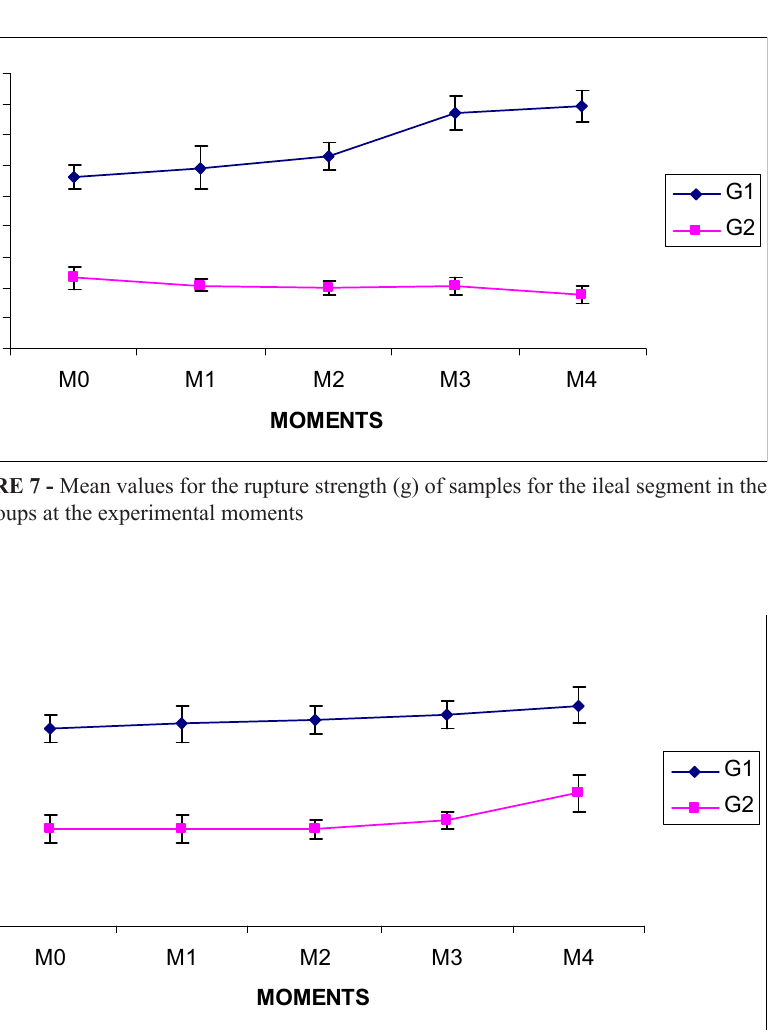
FIGURE 8 - Mean values for the rupture strength (g) of samples for the distal colon in the two groups at the experimental